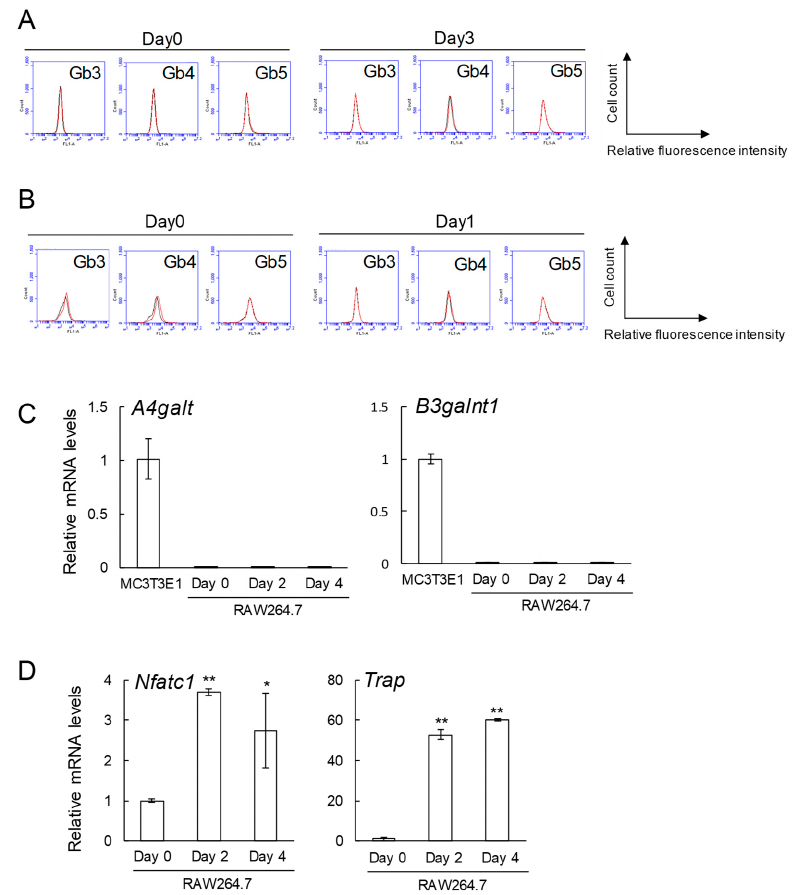
Figure 3. Expression of globo-series glycosphingolipids (Gb3, Gb4, and Gb5), Gb3 synthase gene ( A4galt ) and Gb4 synthase gene ( B3galnt1 ) in RAW264.7 cells and primary cultured pre-osteoclasts in the presence or absence of RANKL. ( A ) Expression of globo-series glycosphingolipids (Gb3, Gb4, and Gb5) in RAW264.7 cells on days 0 and 3 after administration of RANKL by flow cytometric analysis. ( B ) Expression of globo-series glycosphingolipids (Gb3, Gb4, and Gb5) in primary cultured pre-osteoclasts on days 0 and 1 after administration of RANKL by flow cytometric analysis. Red line: anti-globo-series glycosphingolipids (Gb3, Gb4, and Gb5) monoclonal antibodies (mAbs) ( + ), gray line: anti-globo-series glycosphingolipids mAbs (-). ( C ) mRNA expression of A4galt and B3galnt1 in MC3T3 E1 and RAW264.7 cells on days 0, 2, and 4 after administration of RANKL ( n = 3). ( D ) mRNA expression of Nfatc1 and Trap in RAW264.7 cells on days 0, 2, and 4 after administration of RANKL ( n = 3). Data are expressed as mean ± S.D. The single and double asterisks indicate p < 0.05 and p < 0.01,